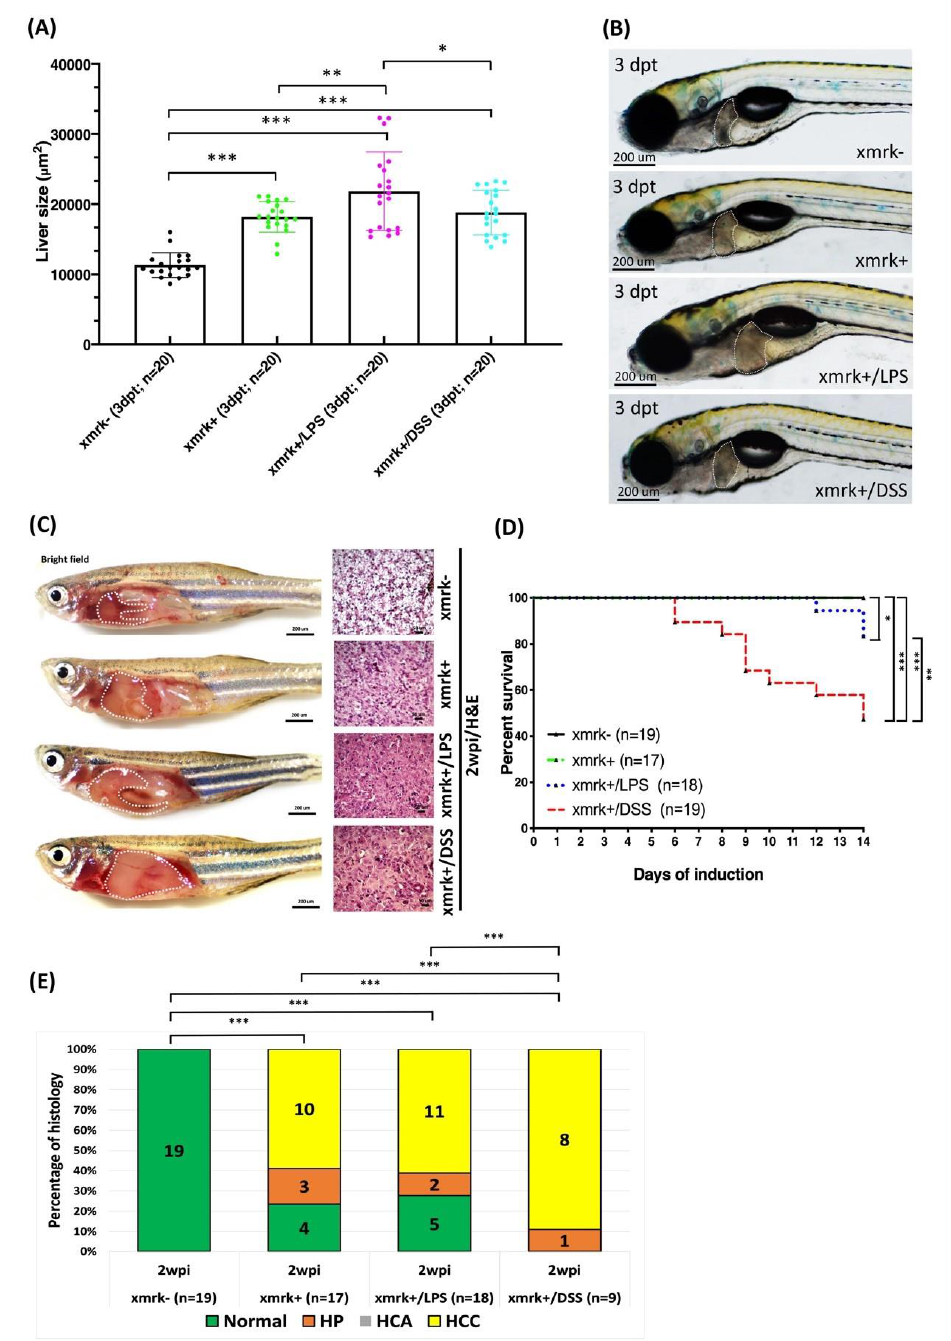
Figure 7. Exposure to LPS or DSS exacerbated the increase in liver size and HCC progression in xmrk + zebrafish. ( A ) Quan- tification and ( B ) representative images of liver size in xmrk +, xmrk +/LPS, and xmrk +/DSS zebrafish larvae as well as xmrk - siblings at 3 dpt. ( C ) xmrk +, xmrk+ / LPS, and xmrk+ / DSS transgenic zebrafish as well as xmrk - control transgenic zebrafish were treated at 4 mpf with 20 µ g/mL Dox plus 40 ng/mL LPS or 0.5% DSS, with samples taken at 2 wpi. The left column shows internal abdominal organs with the livers outlined, and the right column depicts H&E staining of liver sections. Scale bar: 50 or 200 µ m. ( D ) Kaplan–Meier survival curves showing days post-induction plotted against percentage survival to 2 wpi. ( E ) Histological examination confirmed that xmrk +, xmrk +/LPS, and xmrk+/DSS transgenic zebrafish developed HCC at 2 wpi, compared to normal liver histology in xmrk- siblings. Differences among the variables were assessed using Student’s t -tests or one-way ANOVA. Statistical significance: * p < 0.05, ** p < 0.01, *** p <